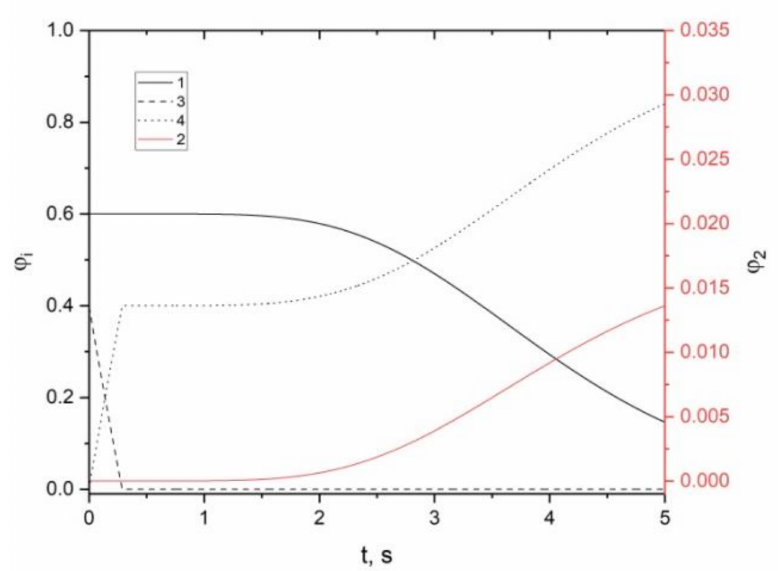
Figure 7. Distribution of volume fractions of phases under the influence of a low-intensity surface forest fire depending on time (summer, July, +20 ◦ C, ϕ 30 = 0.4, α s = 0.03): 1—dry organic matter, 2—soot particles, 3—moisture, 4—gas.